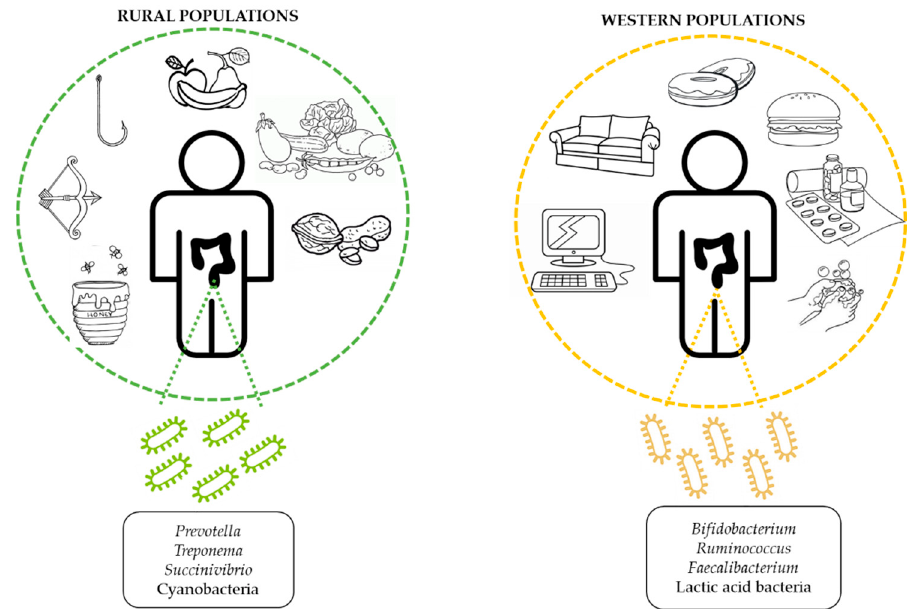
Figure 4. Bacterial profiles and lifestyle factors for rural and urban populations. The geographical area is one of the main drivers of the differences in microbial diversity between populations across the world. On one hand, a large intake of natural products rich in fiber predominates in rural populations, leading to higher levels of taxa involved in fiber processing, such as Prevotella or Treponema. In addition, some opportunistic bacteria such as Succinivibrio and Cyanobacteria are more present in rural populations. Both diet and physical activity influence the different microbiota profiles, including the practice of harvesting, hunting, and fishing. In contrast, urban populations tend to have a less healthy lifestyle characterized by diets high in refined fats and sugars, sedentarism, high intake of drugs, and extreme hygiene, characterized by a gut microbiota enriched in species of Bifidobacterium , Ruminococcus , Fecalibacterium , and acid-lactic bacteria.